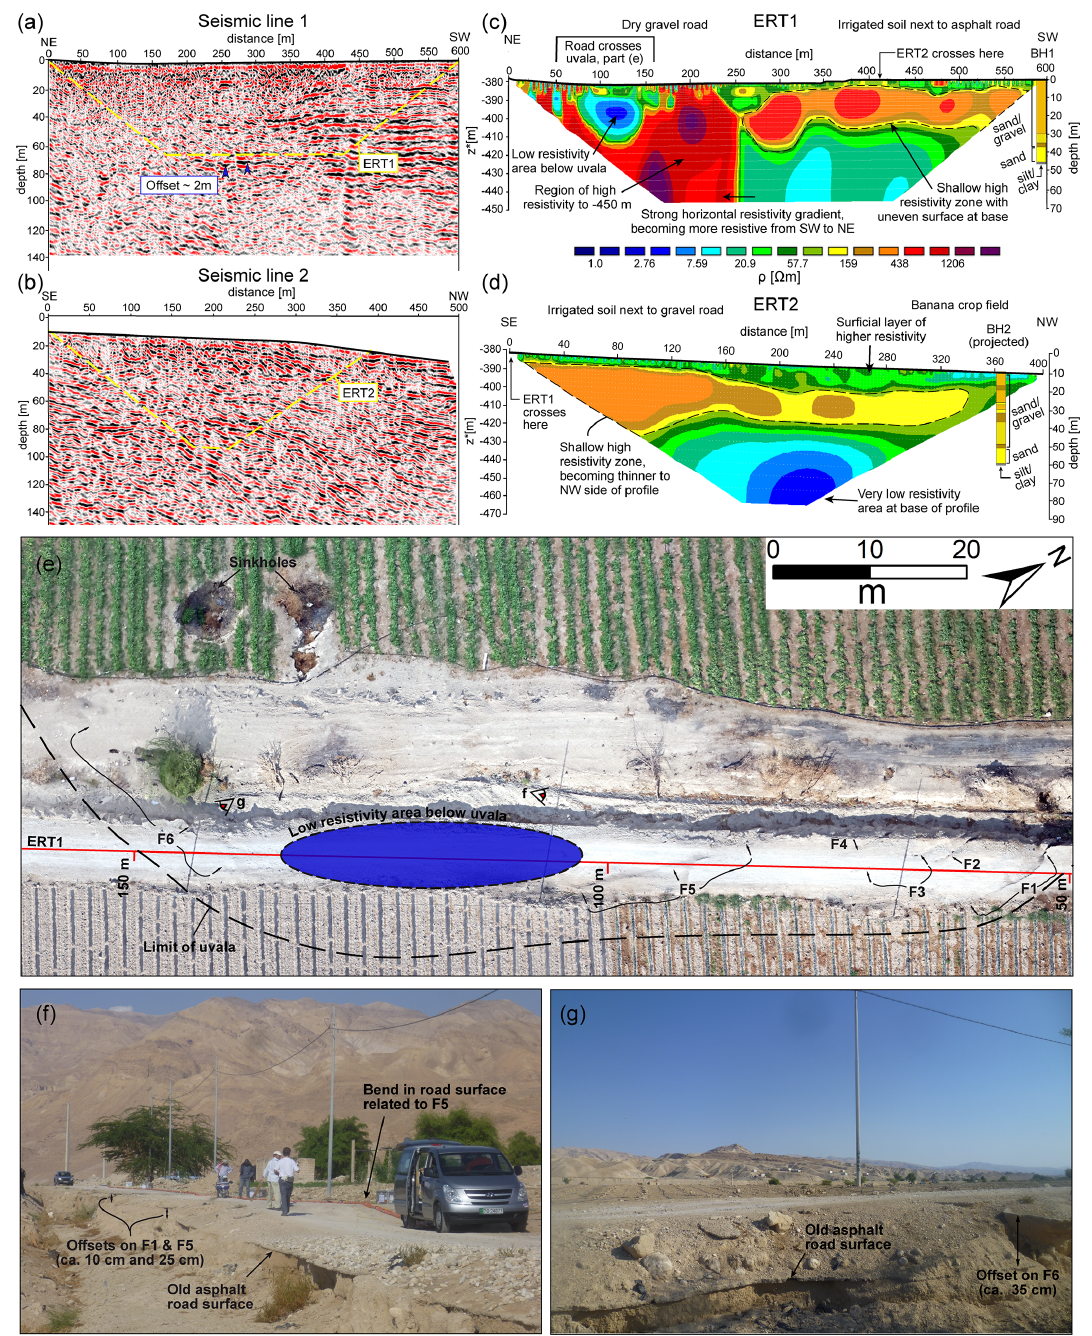
Figure 11. Comparison of shear wave reflection and ERT profiles. (a) Seismic line 1 (modified after Polom et al., 2018b). The inserted yellow trapezoidal area marks the shape of ERT1. (b) Seismic line 2 (modified after Polom et al., 2018b). The inserted yellow trapezoidal area marks the shape of ERT2. (c) Electric resistivity distribution along profile ERT1 achieved by an inversion of apparent resistivities in a Wenner–Schlumberger roll-along configuration with an rms error of 11.9% after nine iterations. (d) Electric resistivity distribution along profile ERT2 achieved by an inversion of apparent resistivities in a Wenner–Schlumberger configuration with an rms error of 3.8% after six iterations. Borehole lithologies of BH1 and BH2 (projected) are derived from El-Isa et al. (1995) and recoloured from Polom et al. (2018). (e) Orthophoto image from 2014 of the damaged section of road crossing the uvala along ERT1. Six main fractures, F1–F6, are identified. (f) Field photo from 2014 of the subsided old asphalt road surface, which is offset on fractures F1 and F5 and locally overlain by the aggregate. (g) Field photo from 2014 of the offset of the old asphalt road surface on fracture F6.